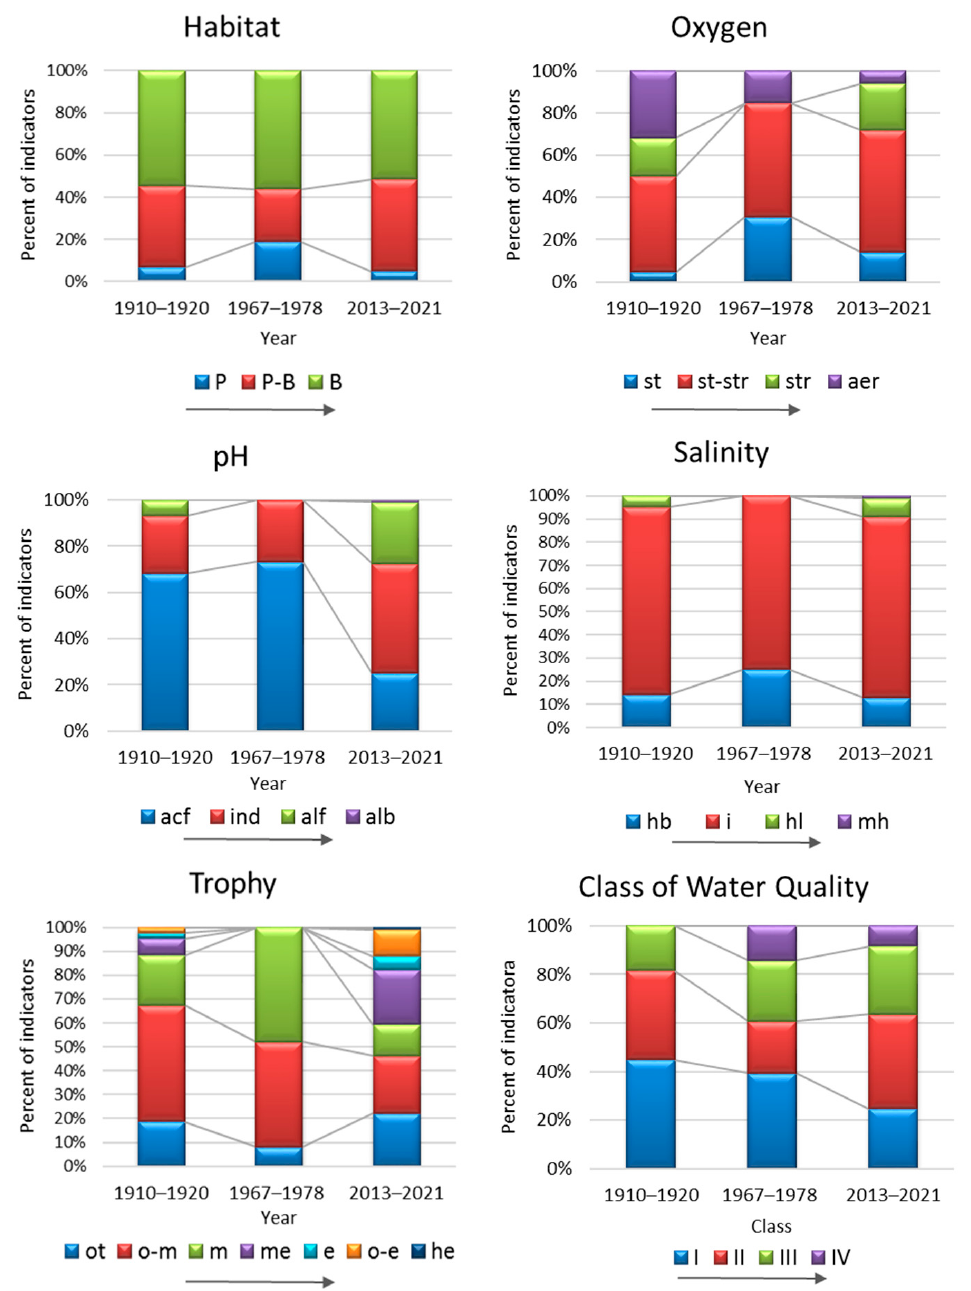
Figure 6. Bioindication plots for ecological analysis of Habitat preference (Habitat): P—planktonic, P-B—plankto-benthic, B—benthic; Streaming and oxygenation (Oxygen): st—organisms that favour standing water with low oxygenation, st-str—organisms that favour low-flow, moderately oxy- genated water; str—organisms that favour streaming water with a high level of